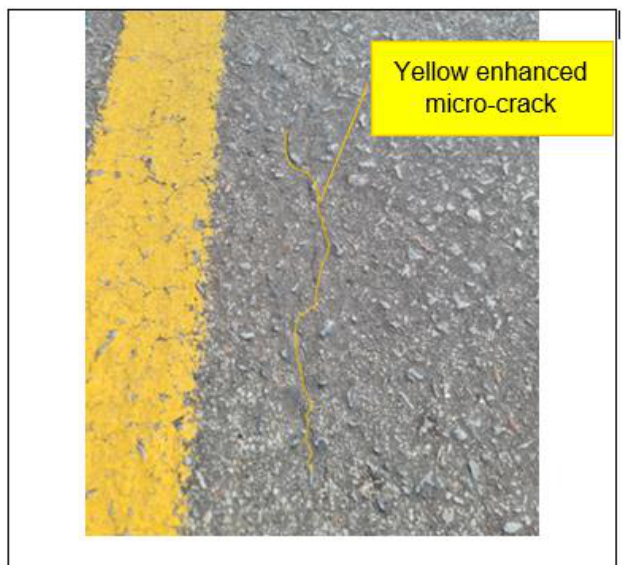
Figure 1. First kind fine hairline/micro cracks on the surface (barely visible).